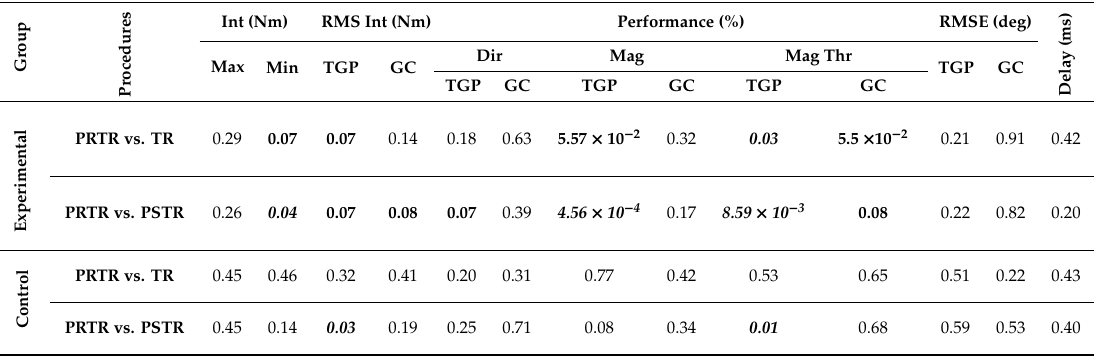
Table 4. The p -values of the statistical tests per metric (maximum ( Max ) and minimum ( Min ) human-robot interaction torque ( Int ); the RMS of Int for training gait phase (TGP) and gait cycle (GC); Performance Dir , Mag , Mag Thr for TGC and GC; RMSE for TGP and GC, and the delay between the reference joint angle and real joint angle), considering a level of significance of 0.05 between PRTR and TR and between PRTR and PSTR for the experimental and control groups regarding the user participation biofeedback strategy. The most representative results ( p -value < 0.10) appear in bold and significant results ( p -value < 0.05) appear in italic